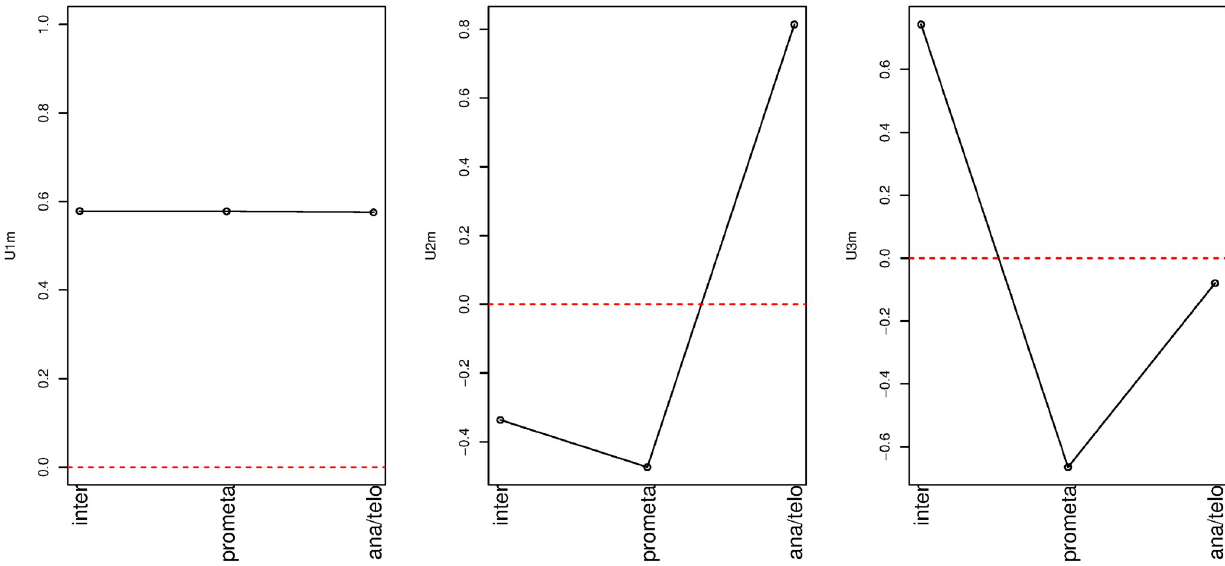
Fig 5. Singular-value vectors associated with cell cycle phase. Left: u 1 m , middle: u 2 m , right: u 3 m .